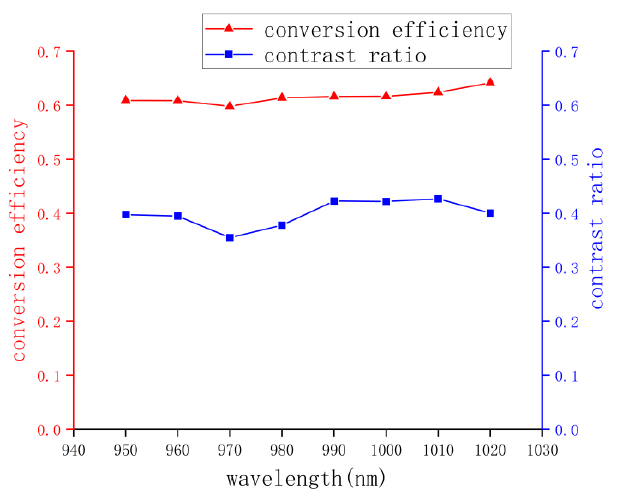
Figure 12. The conversion efficiency (red, y -axis on the left) and the contrast ratio (blue, y -axis on the right) of DG wavelengths from 950 nm to 1020 nm.